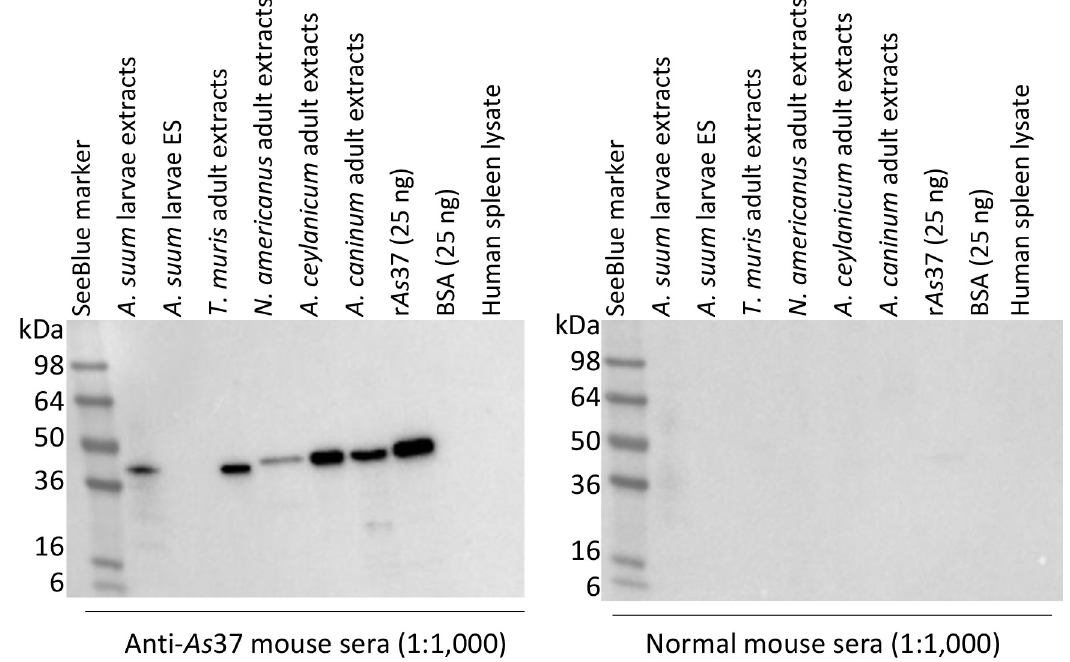
Fig 2. Western blot analysis showing the recognition of native As37 in A . suum lung larval extracts (10 μ g) and its homologs in other nematode extracts (10 μ g) by anti-As37 mouse sera (1:1,000) (left), but not by normal mouse serum at the same dilution (right). SeeBlue prestained proteins used as a protein marker. The antisera strongly recognized rAs37 (25 ng), but not BSA (25 ng) and human spleen lysate (10 μ g).